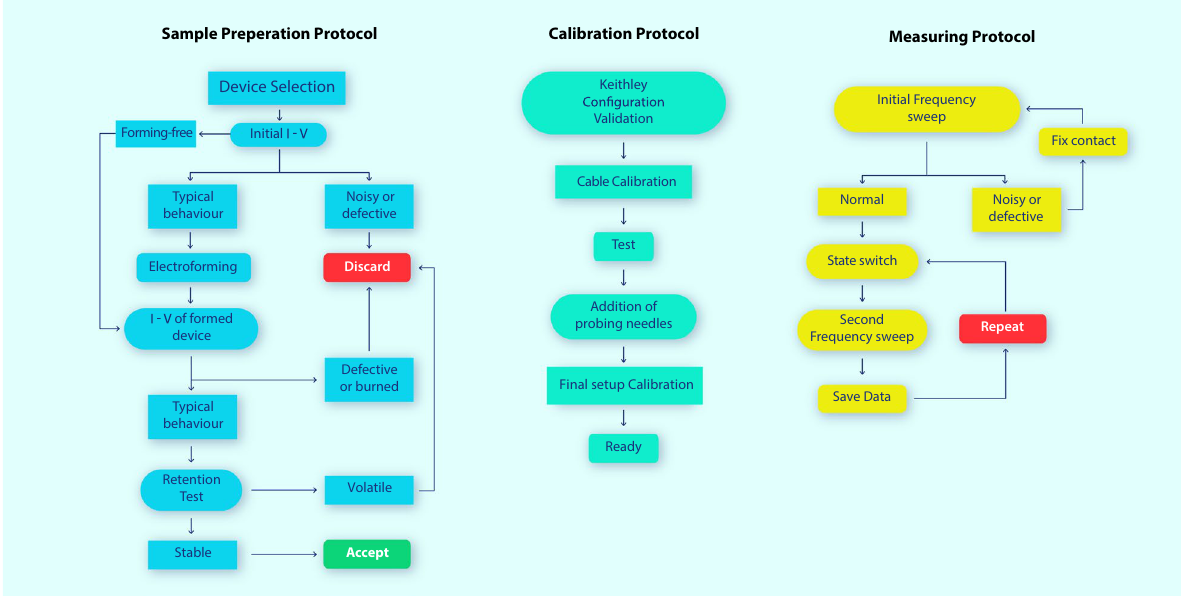
Figure 3. Block diagram representing the decision making process during sample preparation, equipment calibration and measurement protocol. Following the same steps ensures repeatability and limits erroneous